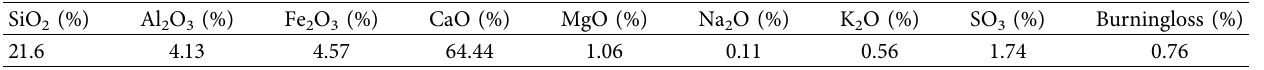
Table 1: Chemical composition of cement.